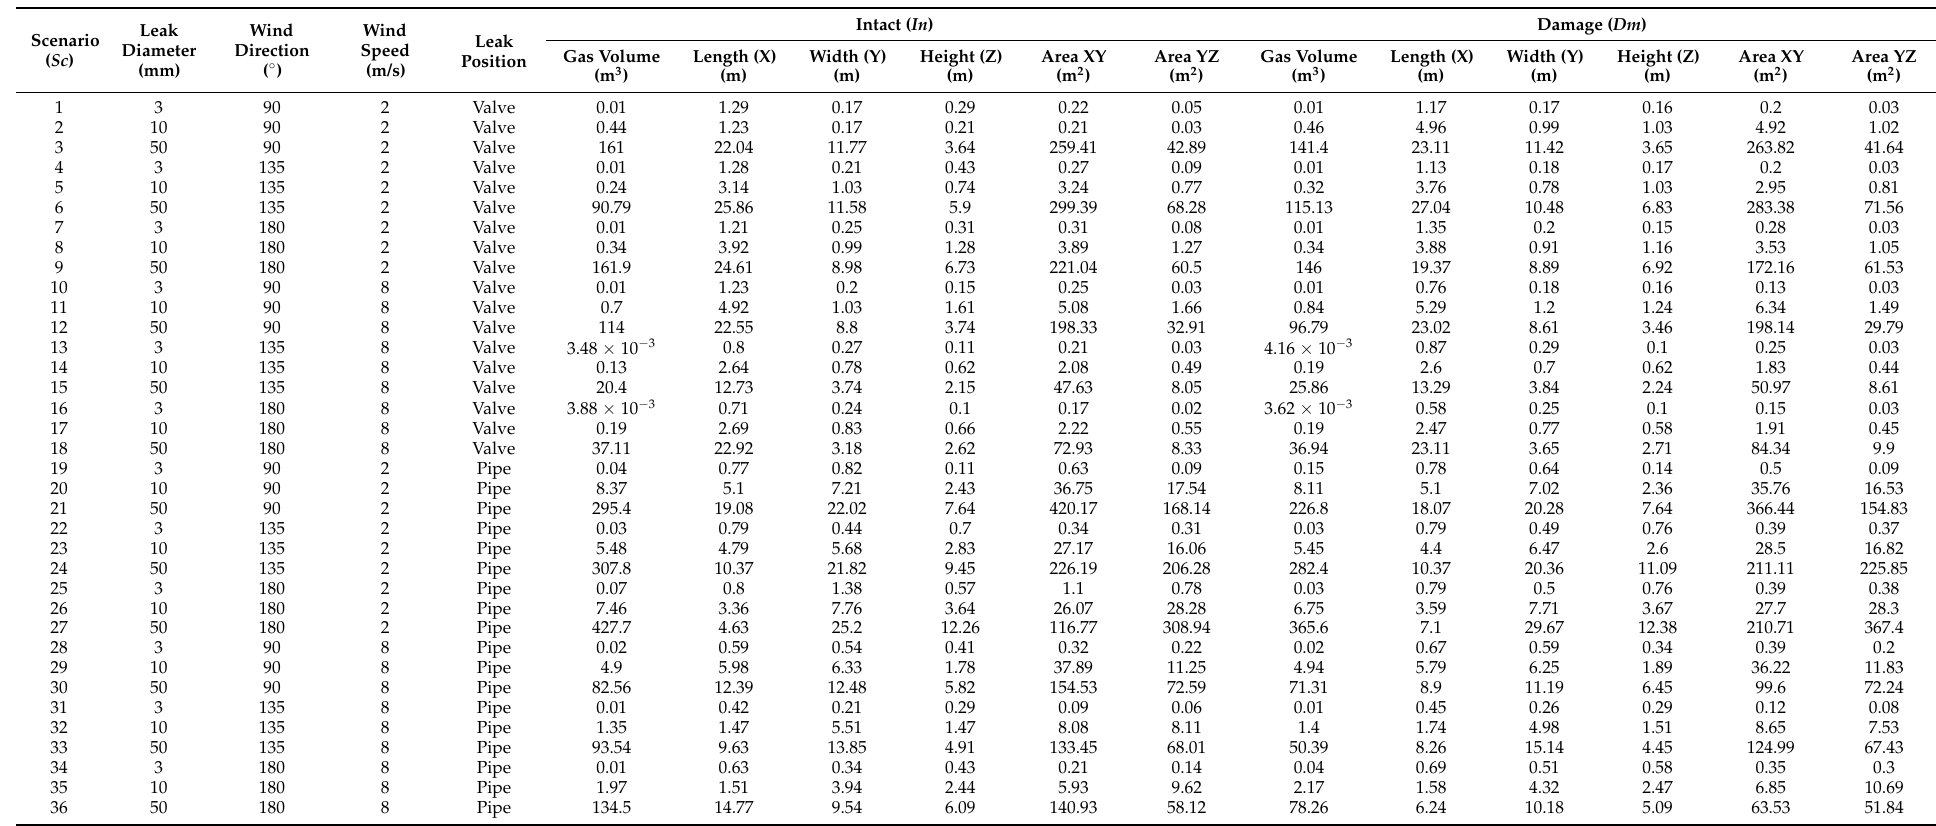
Table 10. Summary of the critical zone and gas cloud